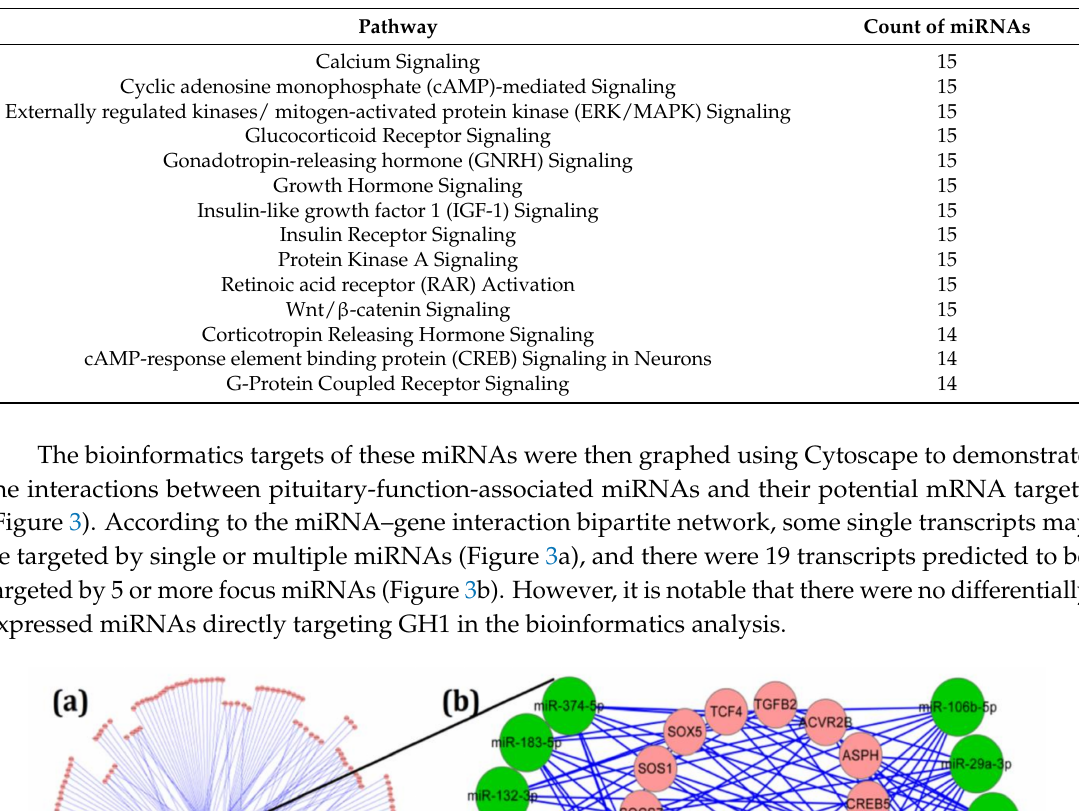
Table 1. Pituitary-function-related pathways regulated by aging-associated miRNAs.